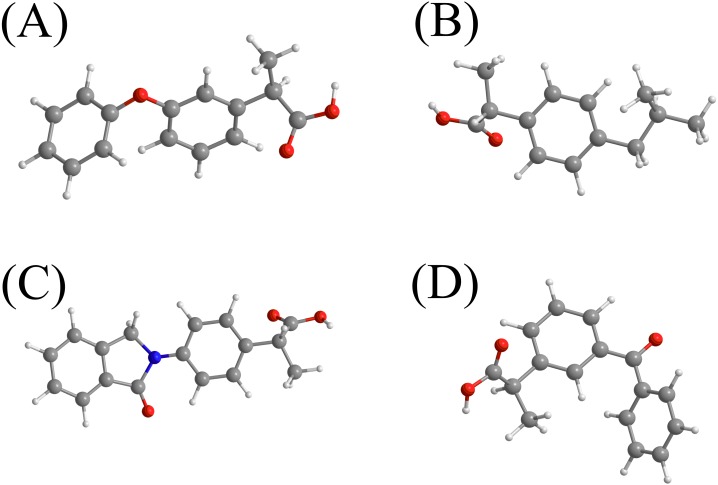
The chemical structures of the selected NSAIDs and pKa-value.(A) fenoprofen (pKa = 4.50)b; (B) ibuprofen (pKa = 4.51)a; (C) indoprofen (pKa = 4.40)a; (D) ketoprofen (pKa = 4.20)a. aRef (Cha & Myung, 2013). bhttp://www.drugbank.ca (accessed on 6 th July 2017).